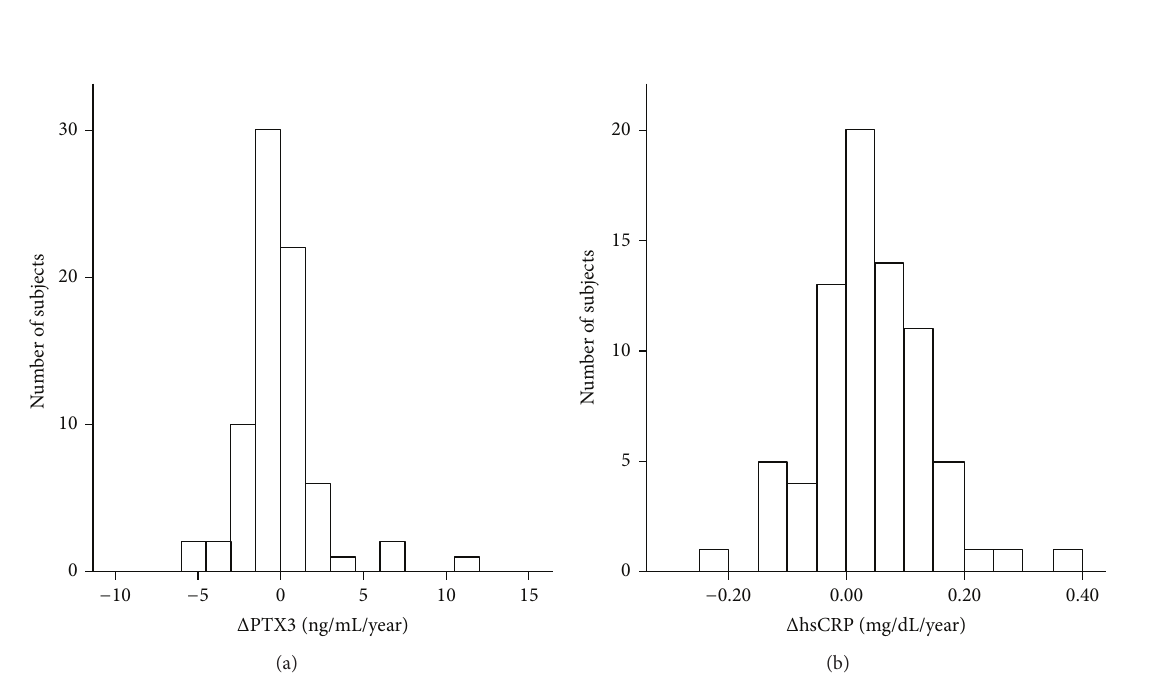
Figure 1: The annual change in pentraxins in the HD cohort. Distribution of annual change in PTX3 levels ( Δ PTX3 (a)) or hsCRP ( Δ hsCRP (b)) of the whole subjects is